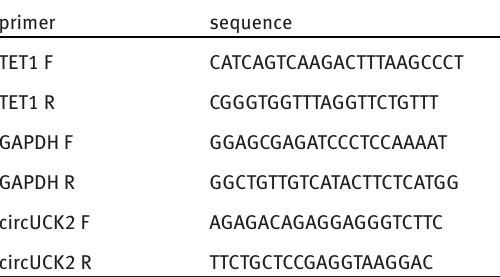
Table 1: Primer sequence for RT-PCR primer